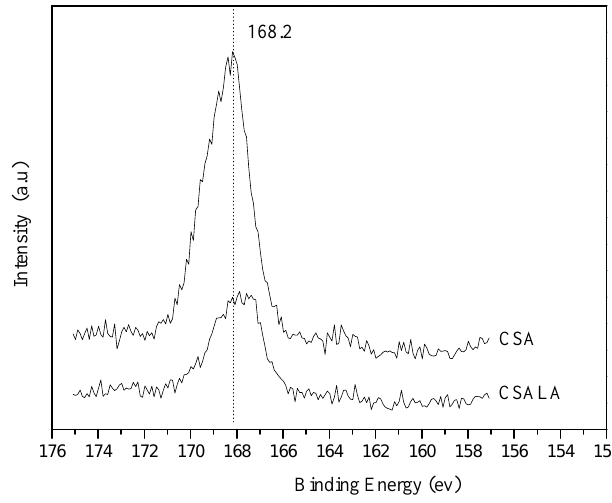
Figure 4. S 2p X ‐ ray photoelectron spectroscopy (XPS) spectra of CSA and CSALA.